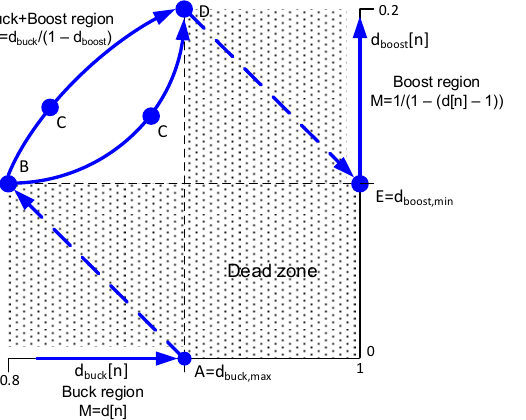
Figure 7. Operation of the 4SBB converter in a (d buck [n],d boost [n]) plain with increasing d[n].